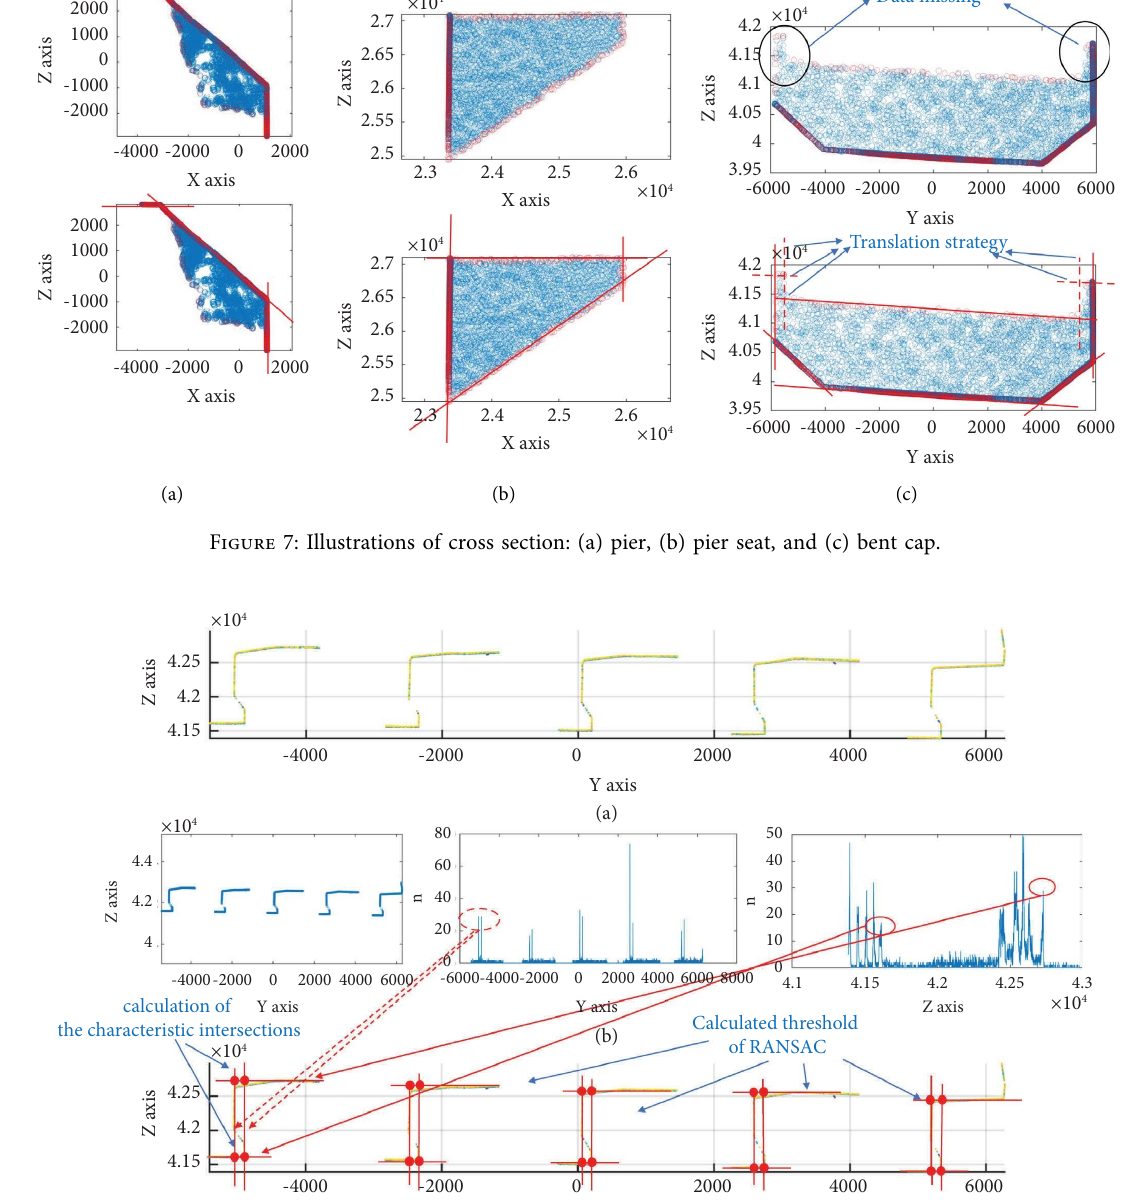
Calculated threshold of